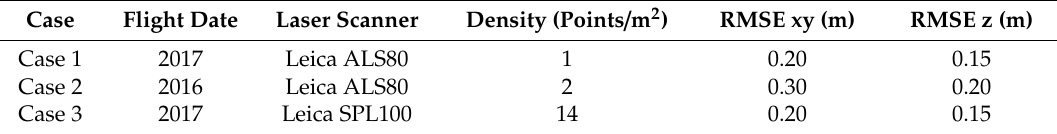
Table 5. Main features of the second coverage LiDAR